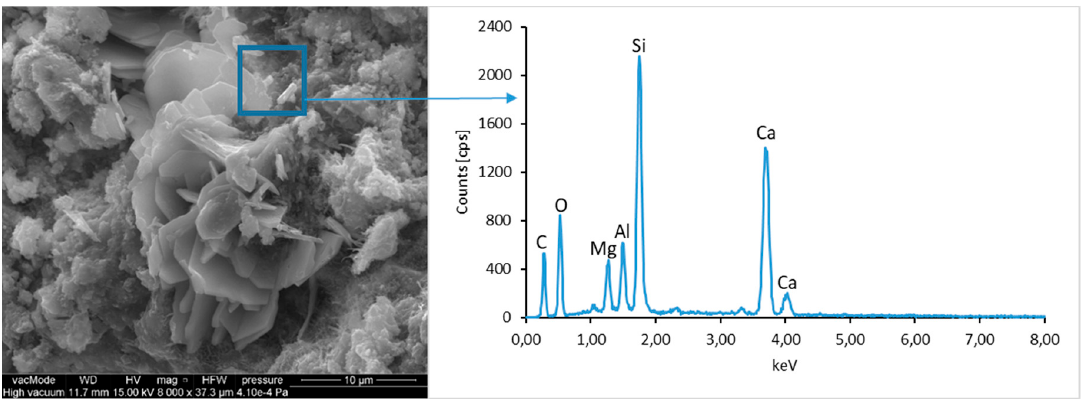
Figure 15. SEM micro-structure of CII.1 concrete and results of elemental analysis in EDS micro-area for visible lamellar portlandite forms forming a rosette embedded in C–S–H phase.